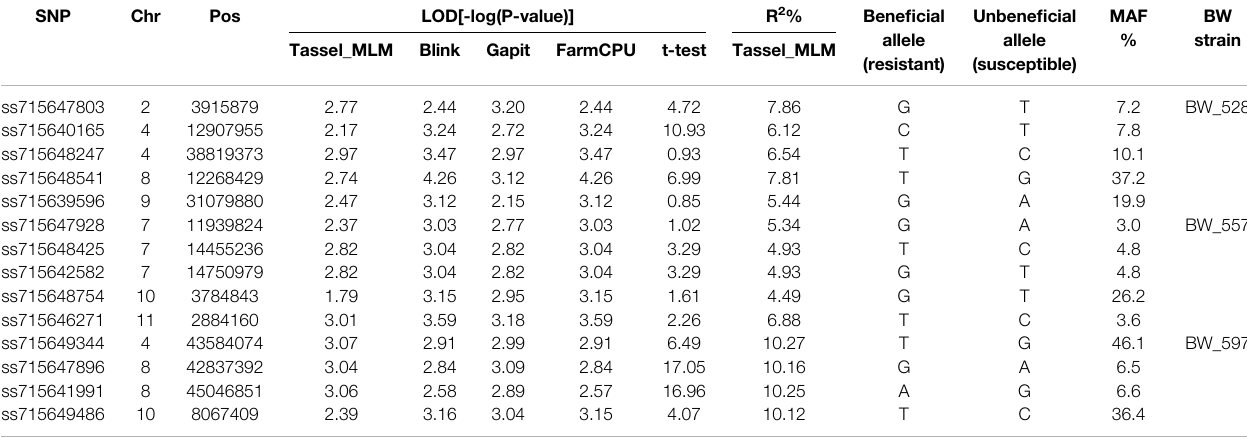
TABLE 2| ListoftheselectedSNP markersassociatedwithresistancetothree bacterial wilt(BW) isolatesB528,B557,andB598in commonbean corecollection obtained from four MLM models in Tassel 5, BLINK, GAPIT, and FarmCPU and a t -test. SNP